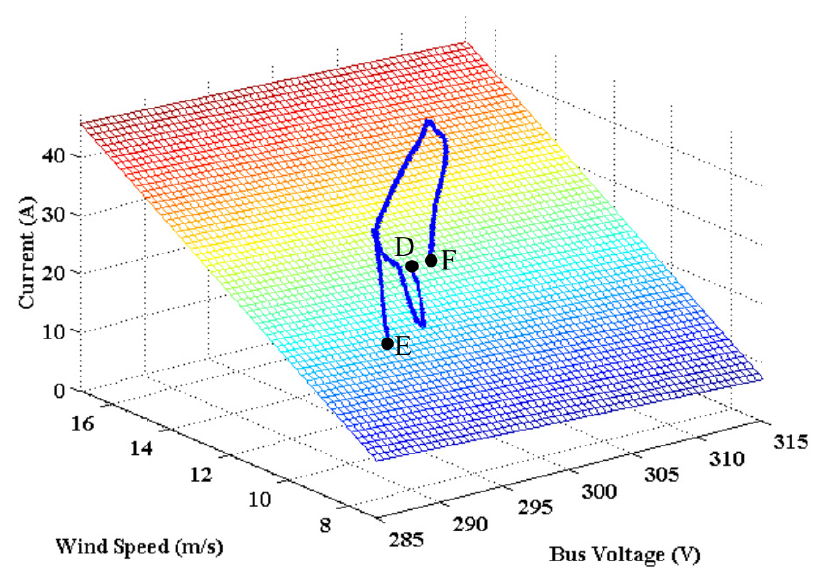
Figure 18. Multidimensional droop control relationship for the second simulation.